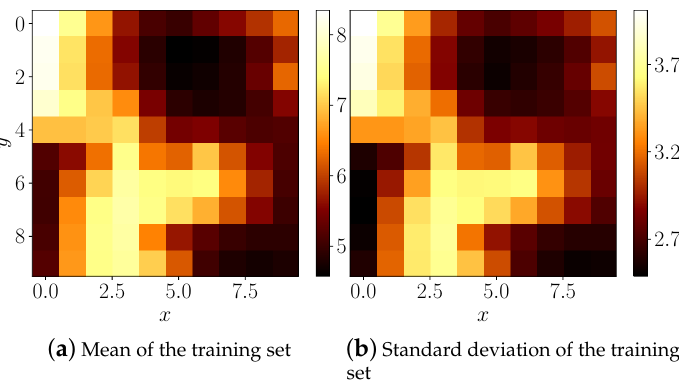
Figure 12. Mean and standard deviation of the training set. Note the higher mean and standard deviation of wind speeds above the sea, compared to the land.